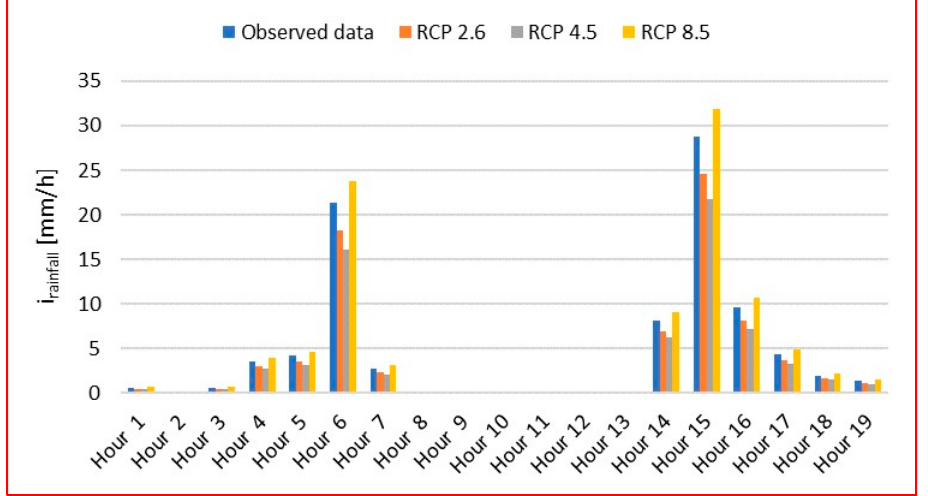
Figure 7. Hyetographs at Sarnico station (4 September 2011 rainfall event): observed data are reported together with the projections in the future climate (RCP 2.6, RCP 4.5 and RCP 8.5). Hyetographs for RCP 2.6, RCP 4.5 and RCP 8.5 were used to evaluate the hydro-